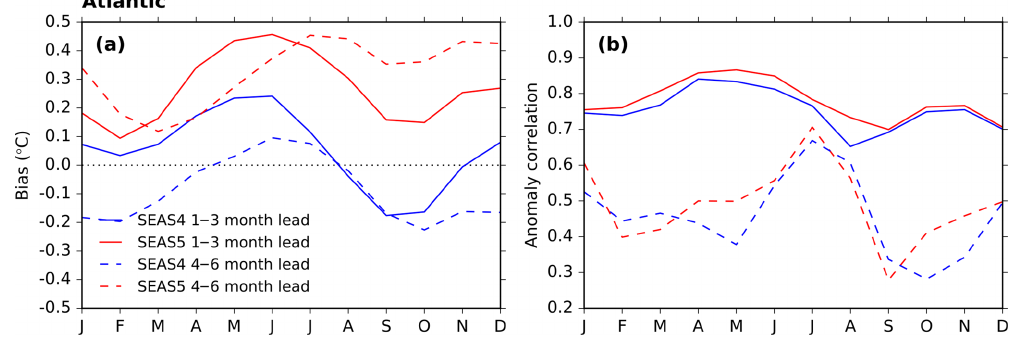
Figure 5. Forecast performance metrics for the tropical Atlantic region (illustrated in Fig. 1) as a function of verification month. (a) SST climatological bias and (b) anomaly correlation. SEAS4 is shown in blue and SEAS5 is shown in red. The solid lines are averaged over 1 to 3 months lead times, and the dashed lines are averaged over 4 to 6 months lead times. Each line uses 15 ensemble members.